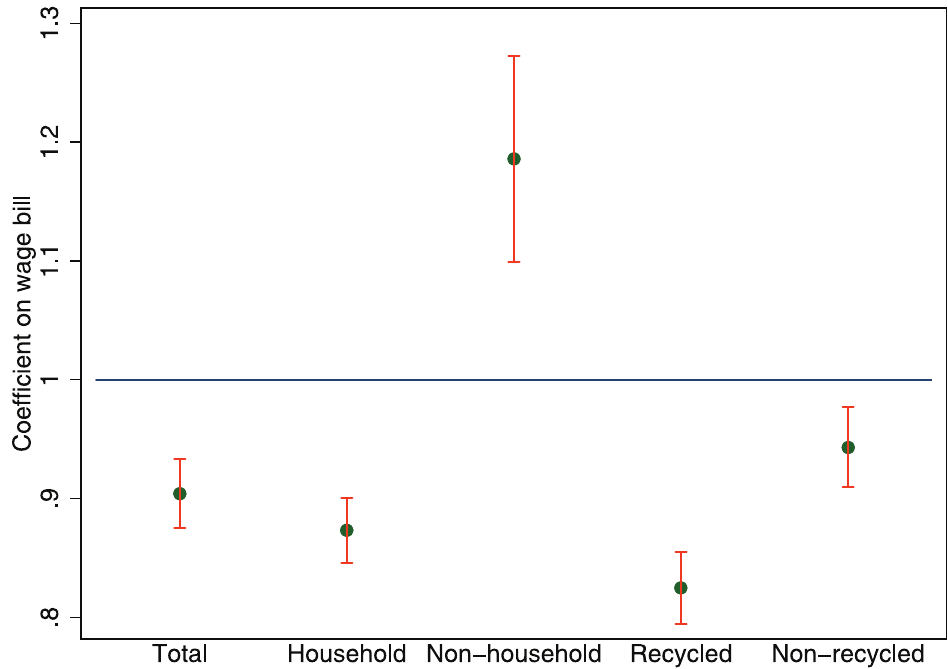
Fig 5. The urban waste premium by source of waste supply (household vs. non-household) and by destination (recycled vs. non-recycled). The scaling coefficients were estimated by OLS and the 95% confidence intervals are shown as red